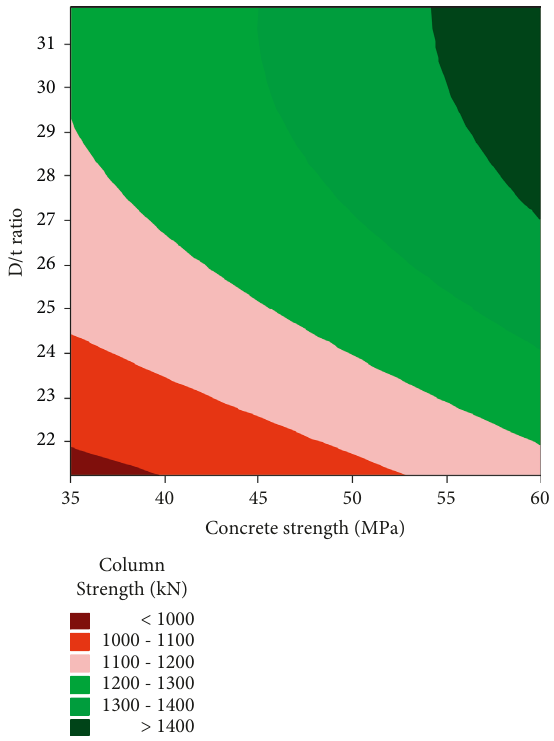
Figure 7: Contour plot examination of the effect of D/t ratio and concrete strength on column